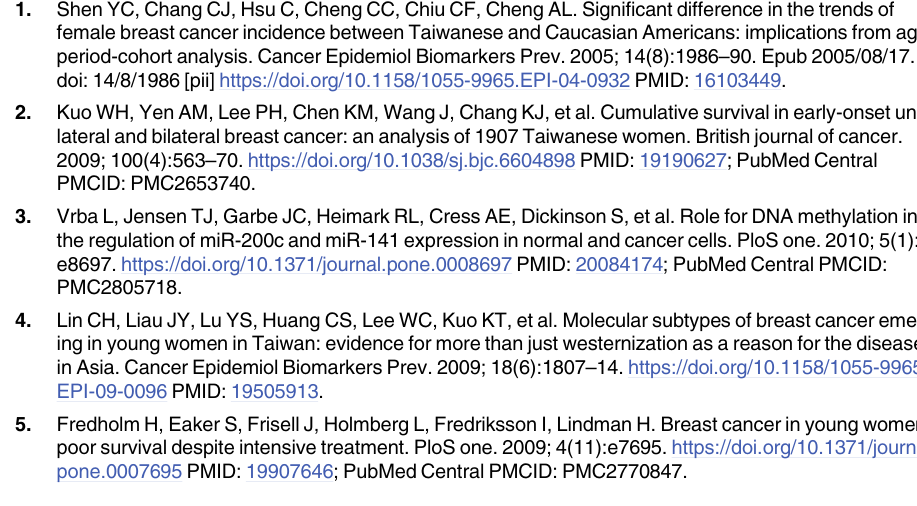
S2 Fig. Unsupervised hierarchical clustering of 6 differentially expressed miRNAs in nor- mal (red; n = 140) and tumor (blue; n = 145) samples. Hierarchical clustering was performed using Squared Euclidean Distance as a distance measure and Ward’s method for linkage analy- sis.